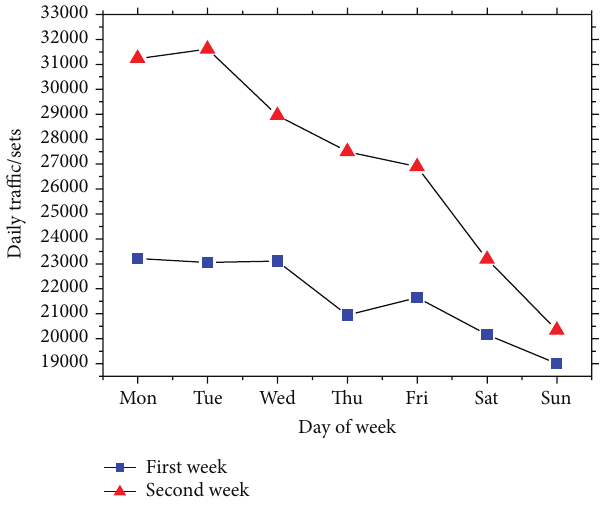
Figure 3: Daily traffic